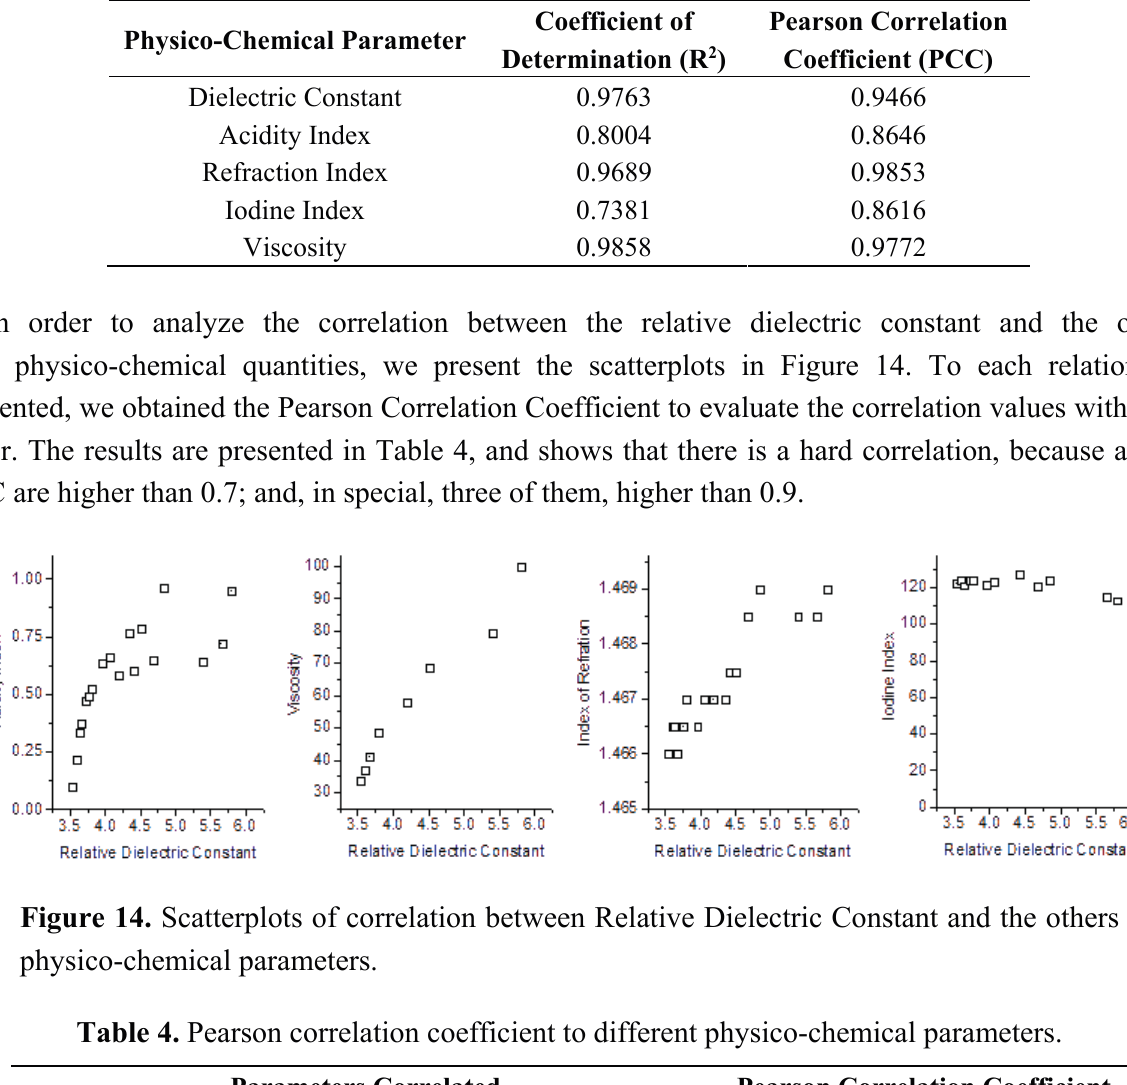
Table 3. Pearson correlation coefficient to different physico-chemical parameters.